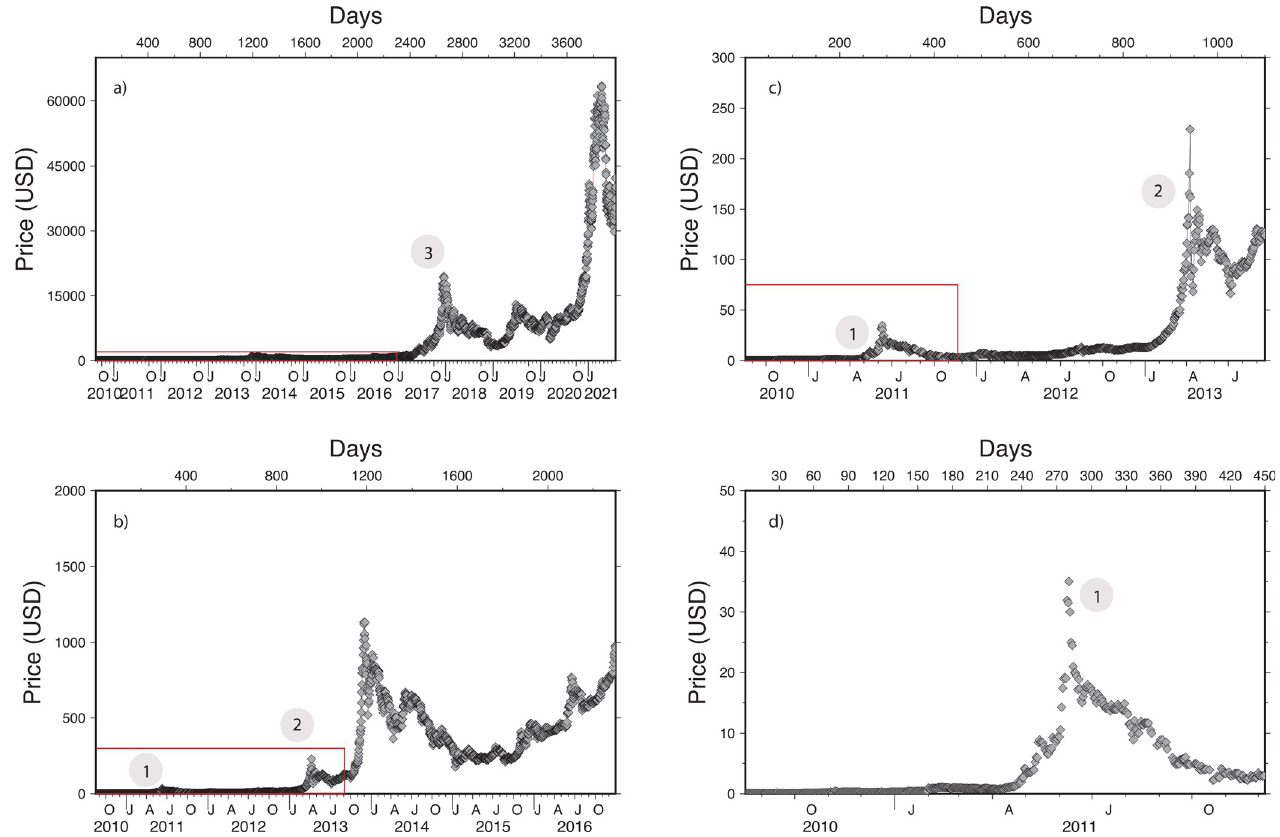
Fig 1. Price of BTC between 2010-08-17 and 2021-07-31 (a) for various periods (b-d). Many periods show the episodes of price increase (and decrease) of similar shape. For reference the same events are highlighted in Fig 2 using same labels.